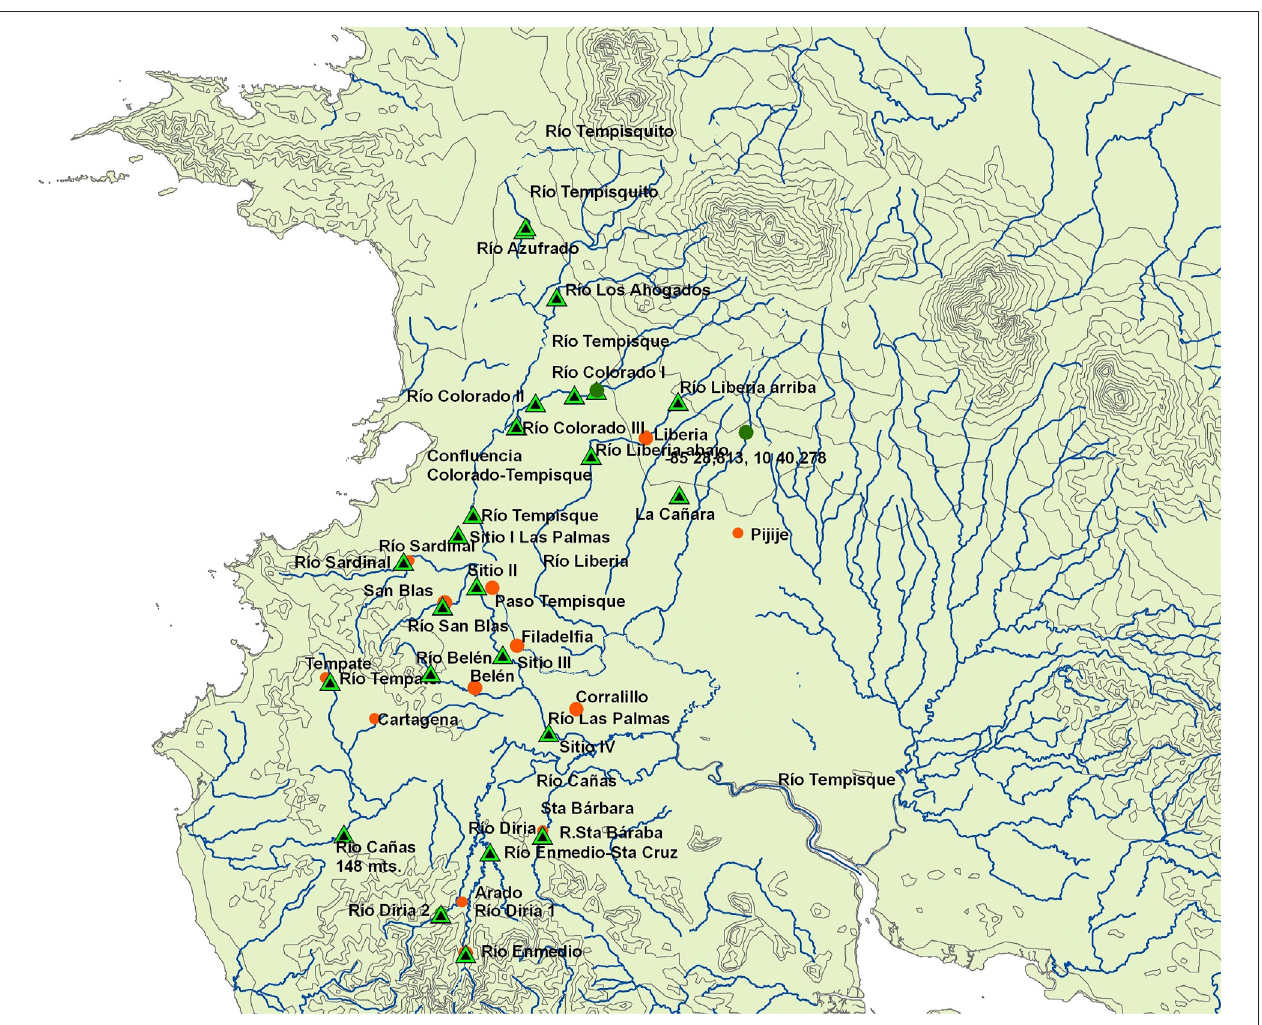
FIGURE 1 | Map of the Tempisque basin study area showing rivers, towns (orange circles), and collecting areas (black-green triangles).